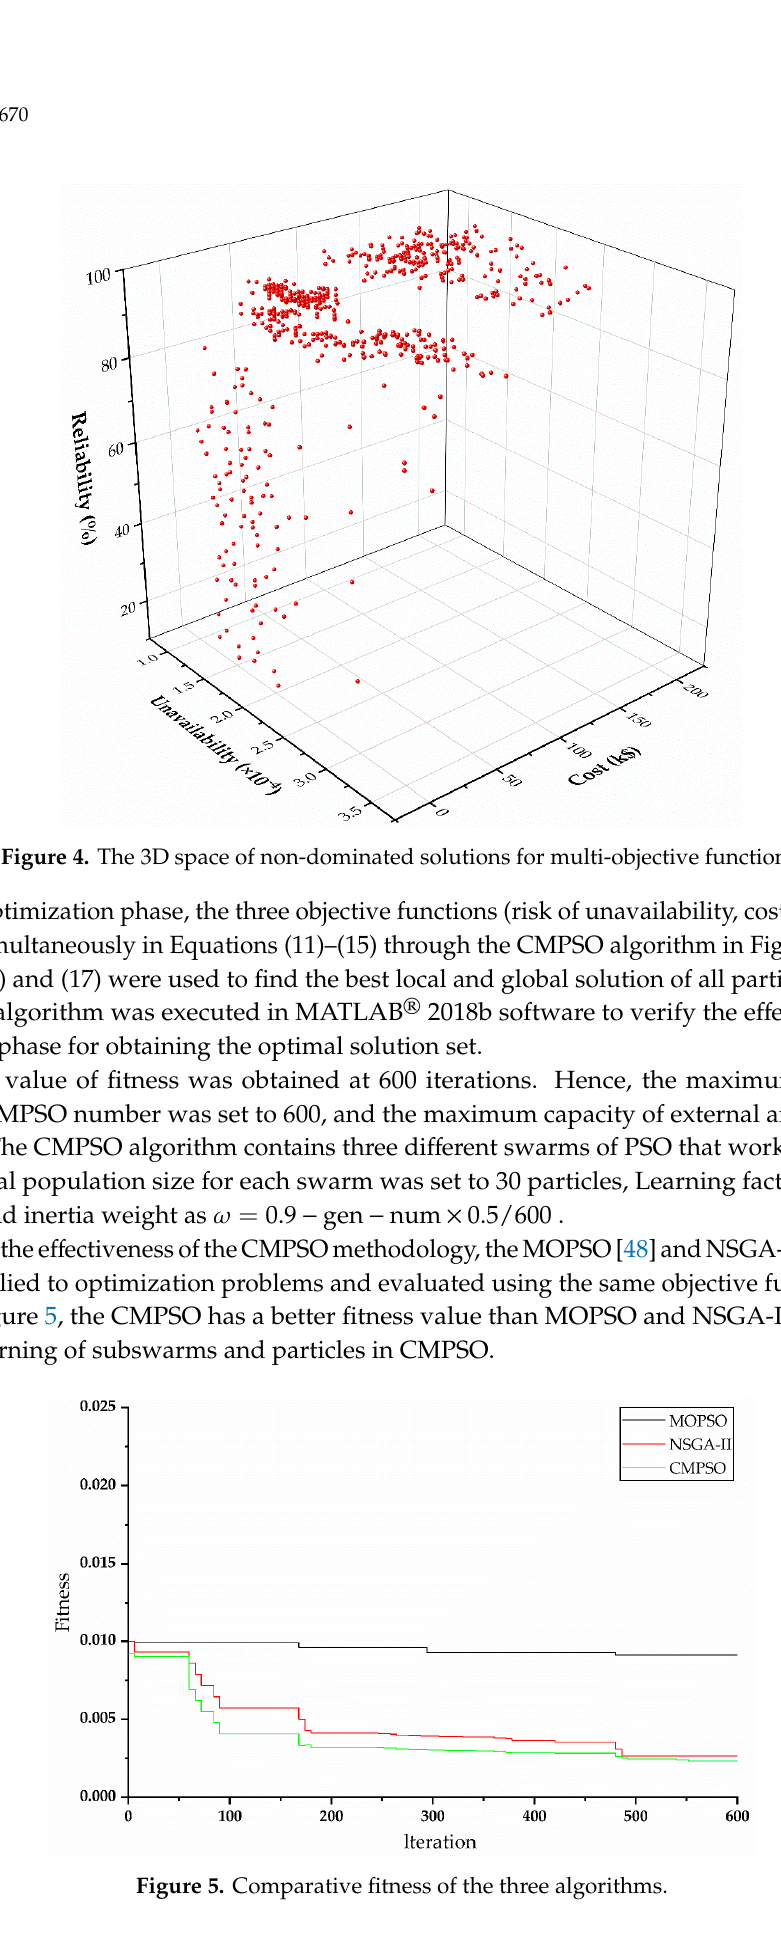
Figure 6. Comparative Pareto fronts of cost reliability—dimensional. In Figure 7, the orange squares in the x ‒ y plane represent the two objectives (cost and unavailability), which show contradictory trajectories. As the cost goes up, the risk of unavailability becomes smaller. The green stars in the x ‒ z plane show the contradictory relationship of unavailability and reliability. The blue dots in the y ‒ z plane represent two objectives (cost and reliability) that show a positive relationship of mutual rising. As the cost increases, the reliability rises until it becomes stable.